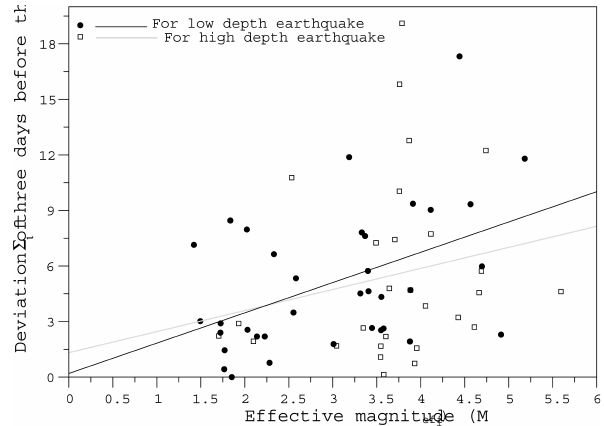
of the Fig. 5. Variations of the deviation of 6 i from the mean value as a i function of the effective magnitudes of the earthquake are plotted. Here we plot the deviation of 6 i of all available data exactly three days before seismic events. The dark circles are for epicenters less than 30km and open boxes are for epicenters above 30km. The solid line is the best fit of all the points for which the earthquakes are at low depths (i.e. epicenters less than 30km). The grey line is the best fit of all the points for which earthquakes are at high depths < 1 . 5, the deviation is neg- (i.e., epicenters above 30km). For M eff i ligible and it monotonically increases with the effective magnitude. A considerable scatter is seen on both sides of the line fitted taking all the